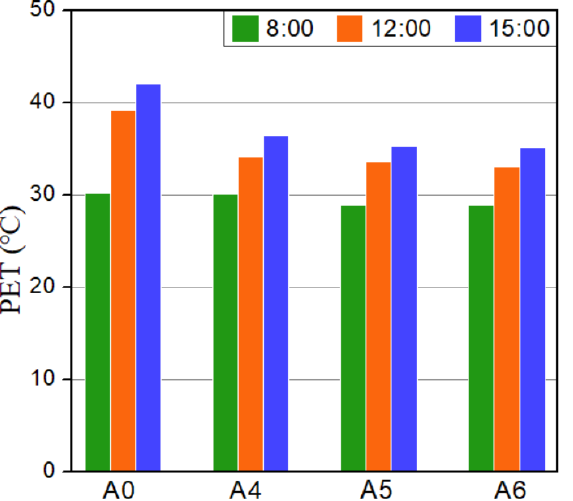
Figure 15. PET of the base case and cases with different H/W at 8:00, 12:00, and 15:00.